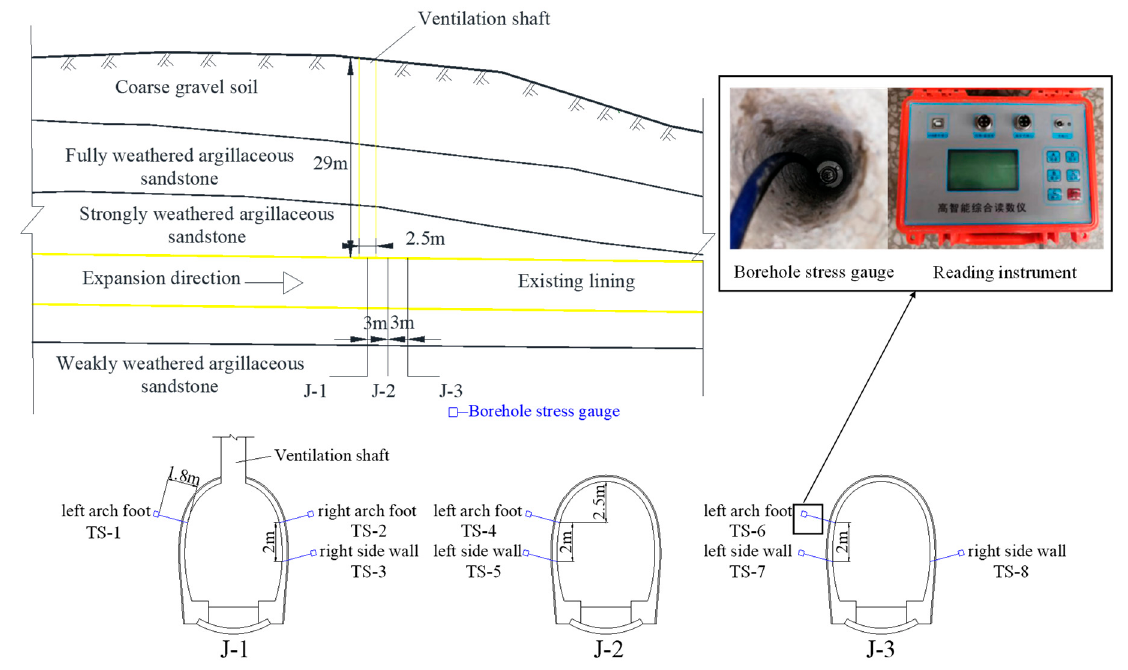
Figure 3. The layout of the borehole stress gauge.